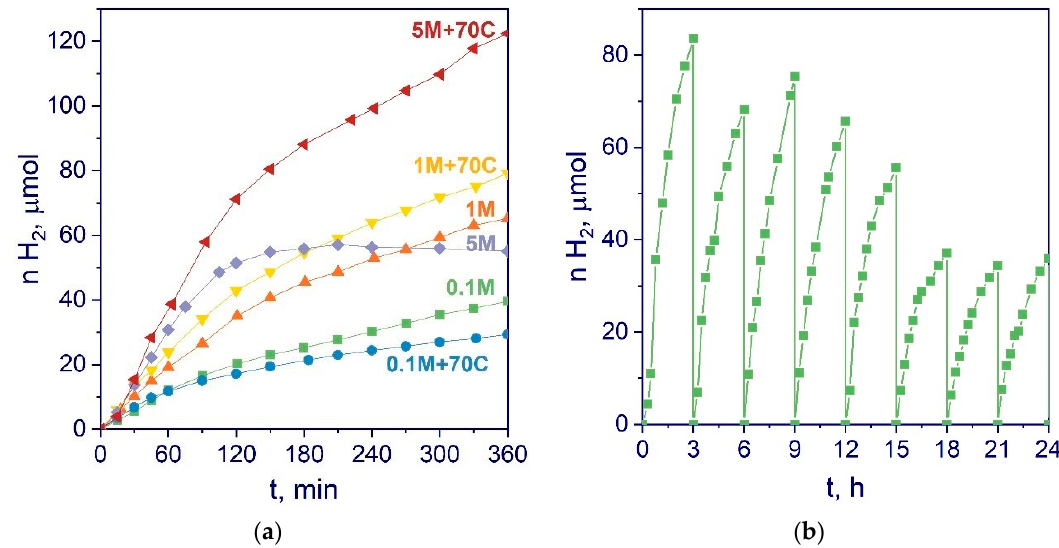
Figure 5. ( a ) The kinetic curves of H 2 evolution from corn starch aqueous suspensions at different NaOH concentrations, with pretreatment at 70 °C and without pretreatment. Conditions: C 0 (starch) = 5 g·L − 1 , C(cat) = 2.5 g·L − 1 , V = 20 mL, λ = 450 nm, T = 20 °C; ( b ) the yield of H 2 during consecutive photocatalytic runs. C 0 (starch) = 5 g·L − 1 , C(cat) = 2.5 g·L − 1 , C 0 (NaOH) = 5 M, V = 20 mL, λ = 450 nm, T(starch pretreatment) = 70 °C.